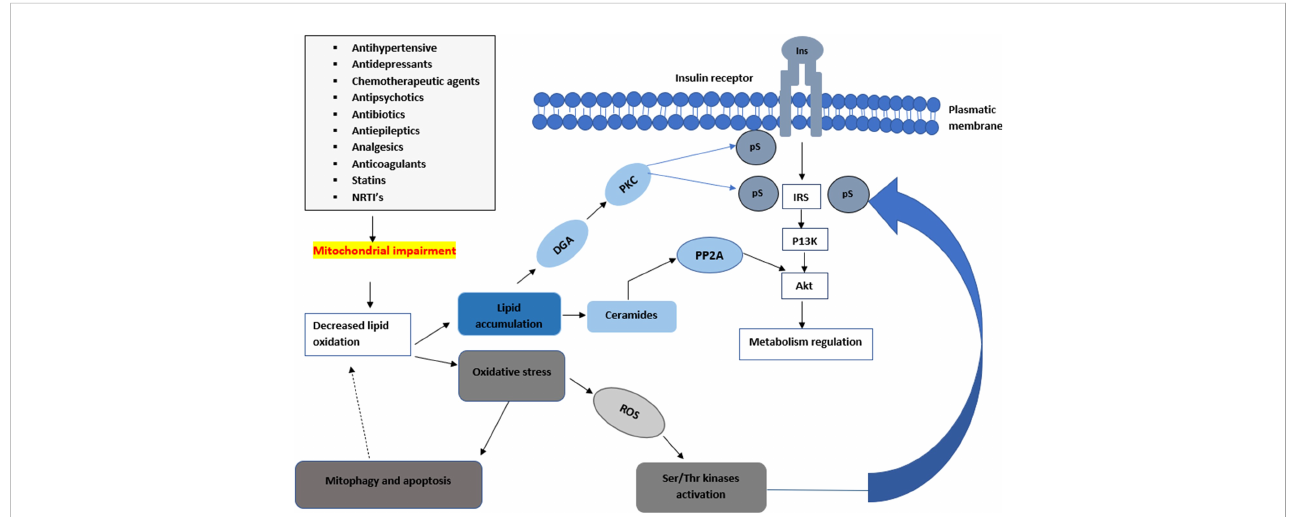
FIGURE 2 An illustration of how mitochondrial impairments can lead to a decrease in insulin sensitivity. Mitochondrial toxicity can lead to a decrease in the metabolism of lipids leading to the accumulation of ceramides and diacylglycerol which lead into the impairment of the insulin signalling pathway. The elevation of these metabolites can lead to a disruption of the insulin signalling pathway through the activation of stress-sensitive kinases such as PKC, ikappaB kinase IKK, and JNK. These stress-sensitive kinases can phosphorylate and inactivate IRS1 and